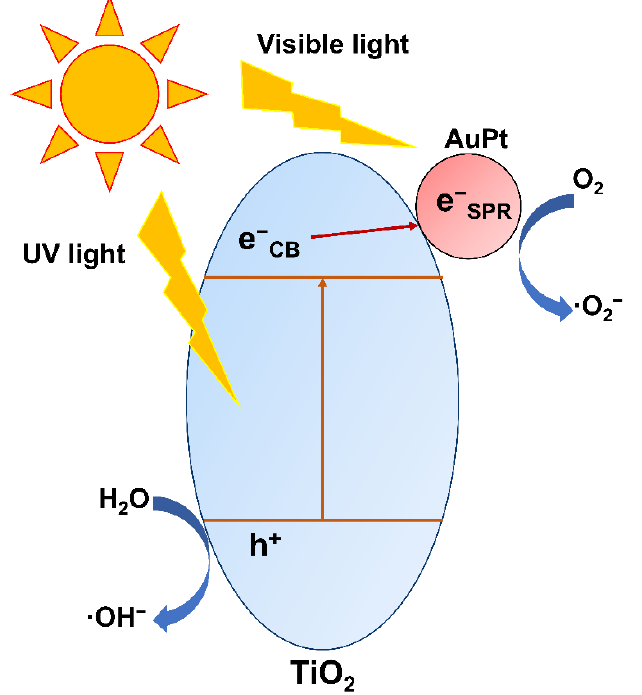
Figure 7. The possible reaction mechanism for photocatalytic degradation of ethylene.